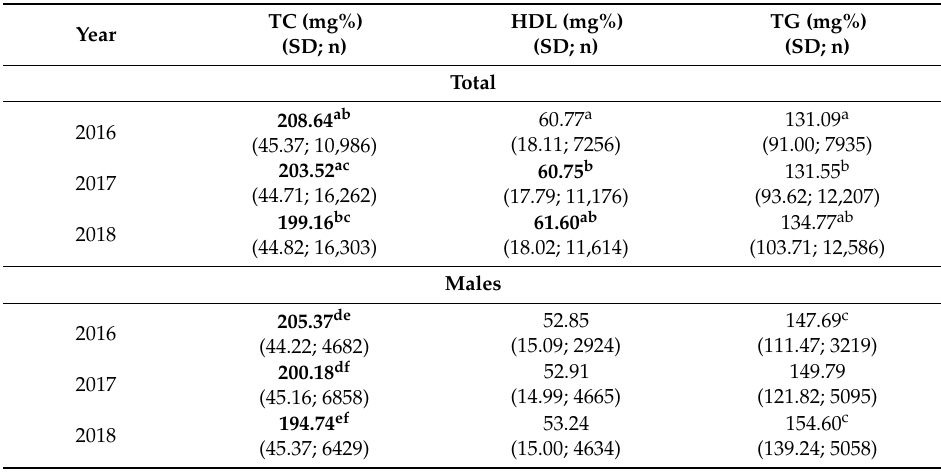
Table 2. Mean values ( ± SD) of lipid parameters (mg%) in consecutive